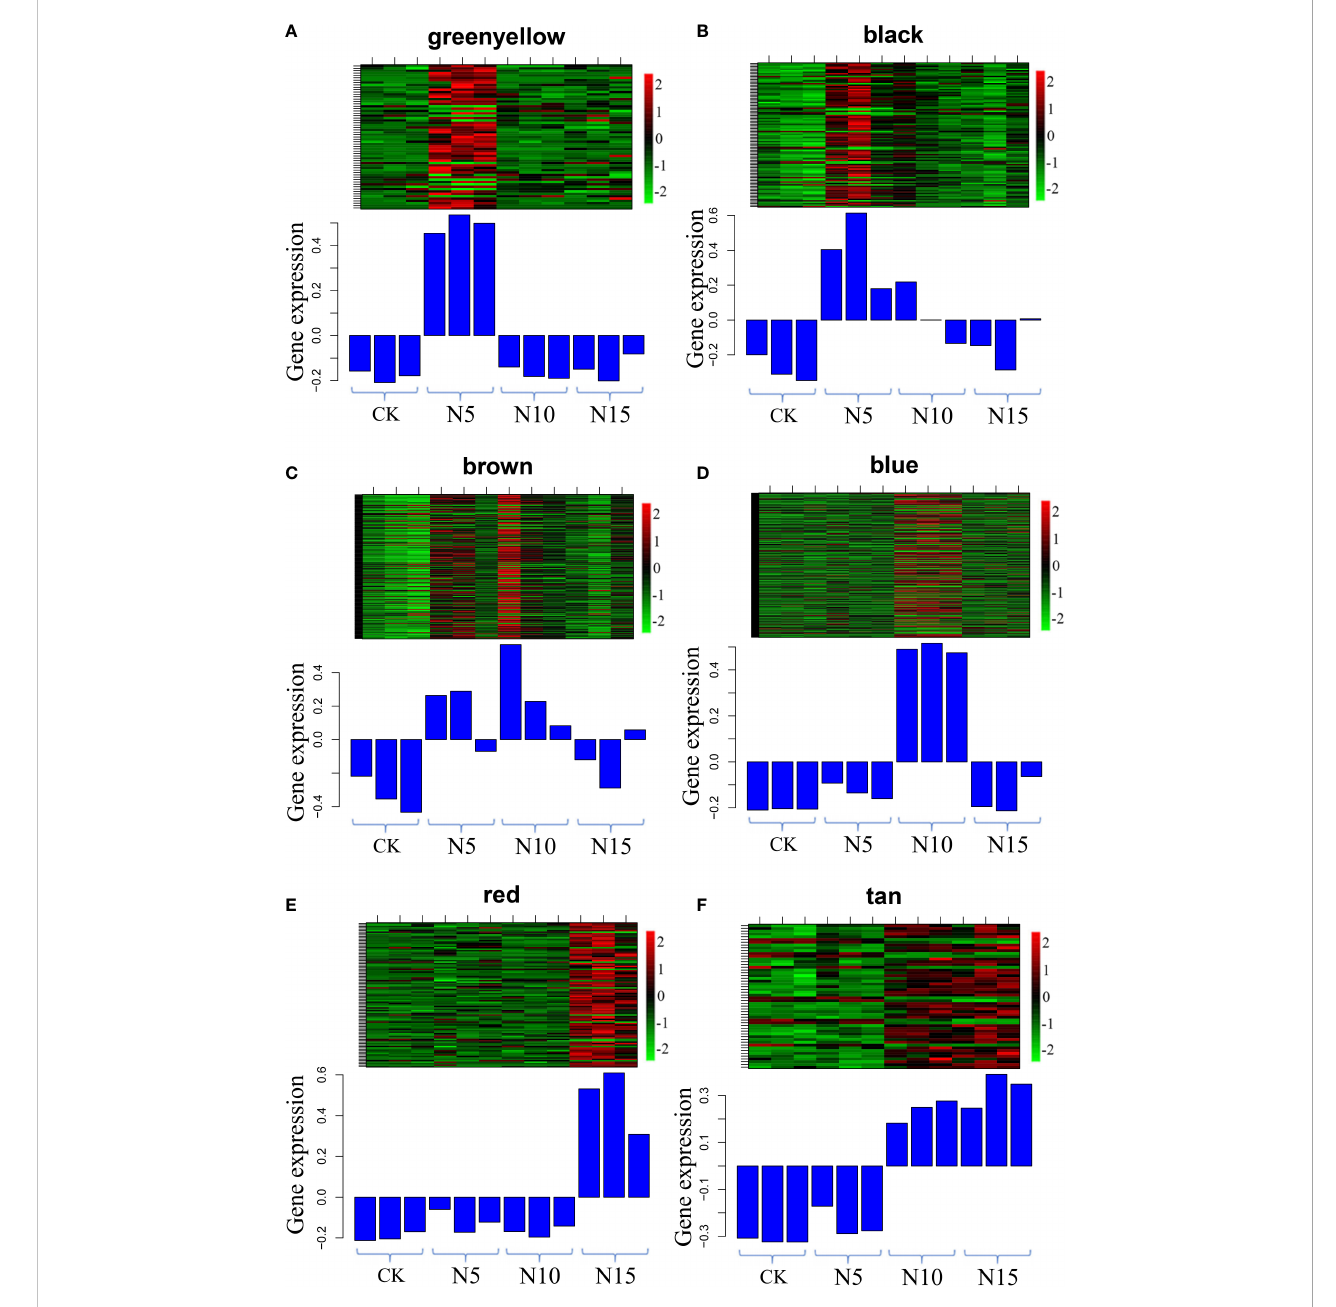
FIGURE 7 Gene expression pro fi les of selected modules. The color bar represent the relative expression, red denotes up-regulation and green denotes down-regulation. (A-F) The modules represented greenyellow, black, brown, blue, red and tan